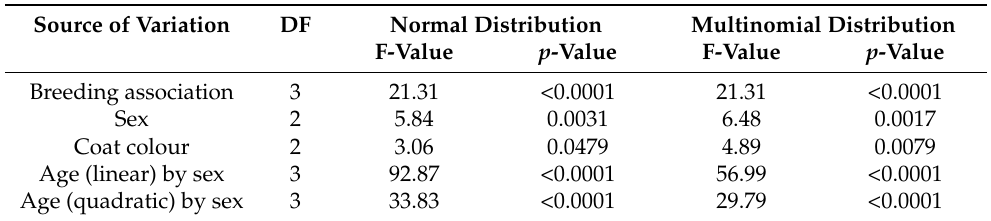
Table 4. Results of the generalized linear mixed model 1 with degrees of freedom (DF), F-values and p -values for CPL-scores in Rhenish German draught